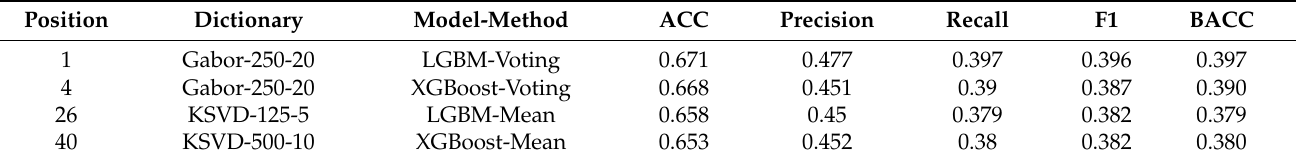
Table 5. Summary of average metrics scores for each data model, class size =